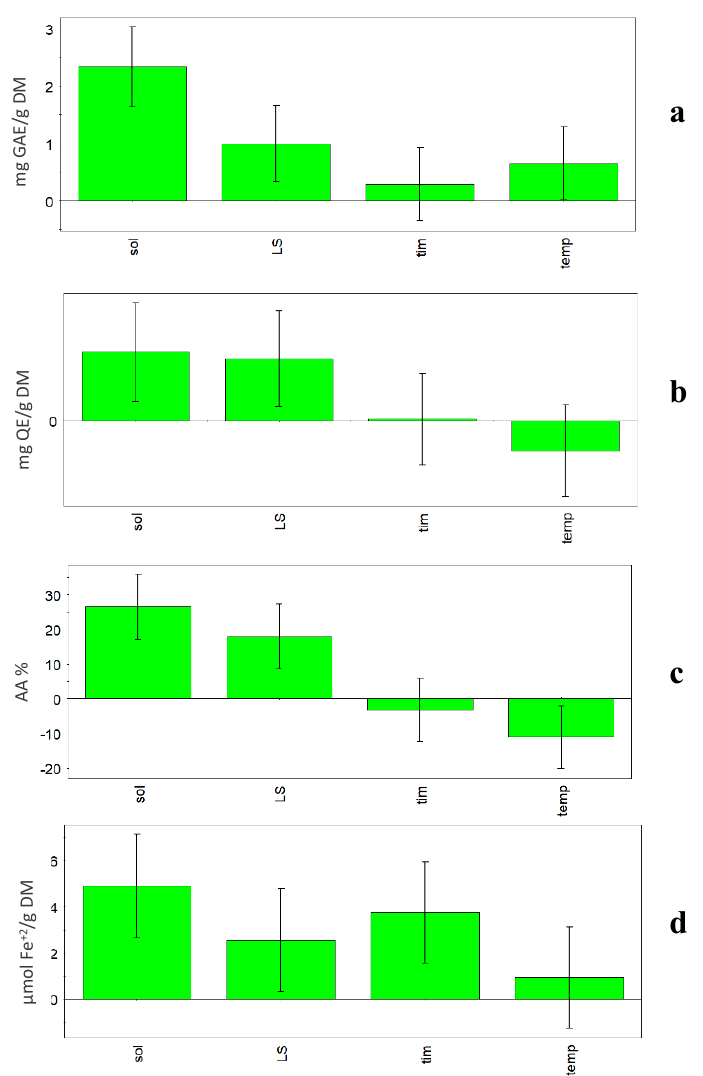
Figure 2. UAE experimental design. Coefficient plots showing the effect of solvent (sol), liquid/solid ratio (L / S), time (tim) and temperature (temp) on the responses: ( a ) TPC, ( b ) TFC, ( c ) FRAP, ( d ) DPPH. Also, TFC content was significantly higher in hydroalcoholic than methanolic extracts ( p < 0.05). L / S ratio was also an influential factor, but only in the case of TFC were the bars of solvent and L / S ratio comparable, so the two parameters showed a comparable influence on the